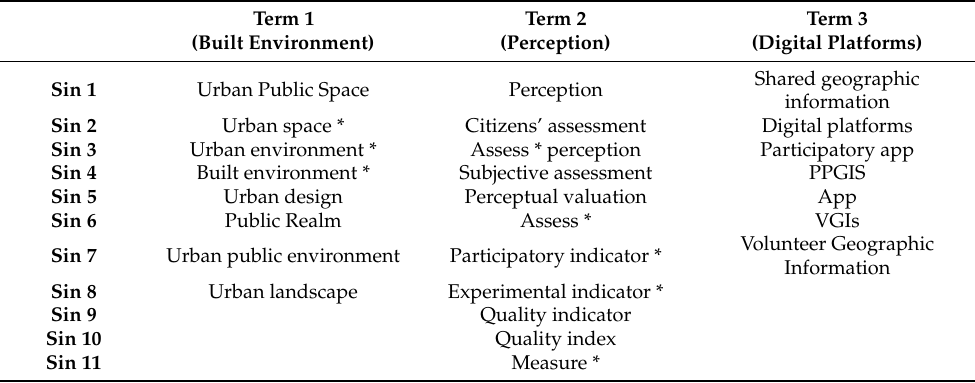
Table 1. Search terminology in WoS and Scopus.